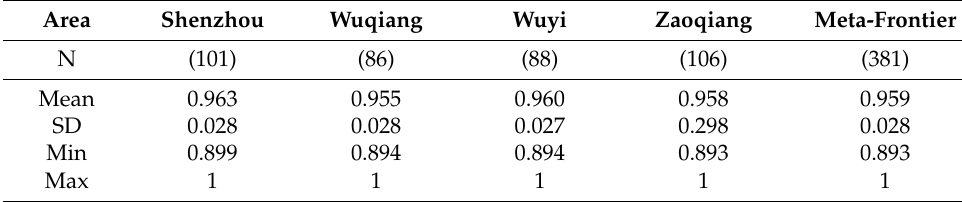
Table 5. Technical efficiency of maize production estimated by DEA.